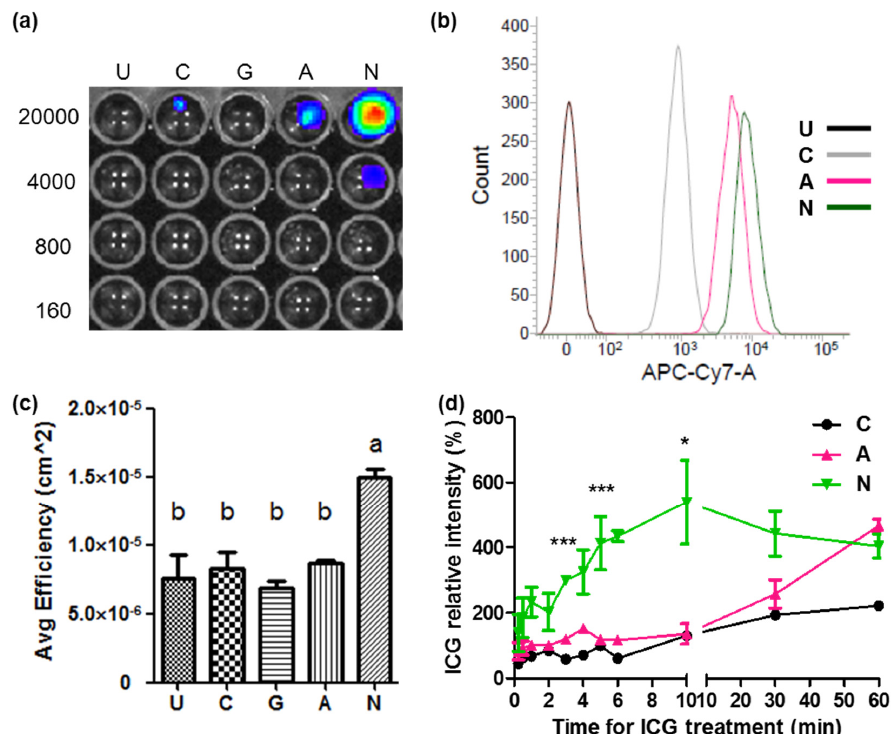
Figure 4. Comparison of ICG intake by ASBT and sodium taurocholate cotransporting polypeptide (NTCP). ( a ) The ICG intensity visualized using the in vivo imaging system (IVIS) at 20,000, 4000, 800, and 160 cell numbers. ( b ) The ICG intensity detected through flow cytometry. ( c ) Quantification of the ICG intensity with IVIS and analyzed using one-way ANOVA. The symbols a and b indicate the groups. ( d ) ICG intensity for different periods of treatment. The significant symbol was ASBT compared with NTCP. U: untreated. G: cells expressing GFP. C: control cells. A: cells expressing ASBT. N: cells expressing NTCP. Error bars depict the SEM, where * p < 0.05 and *** p < 0.001.